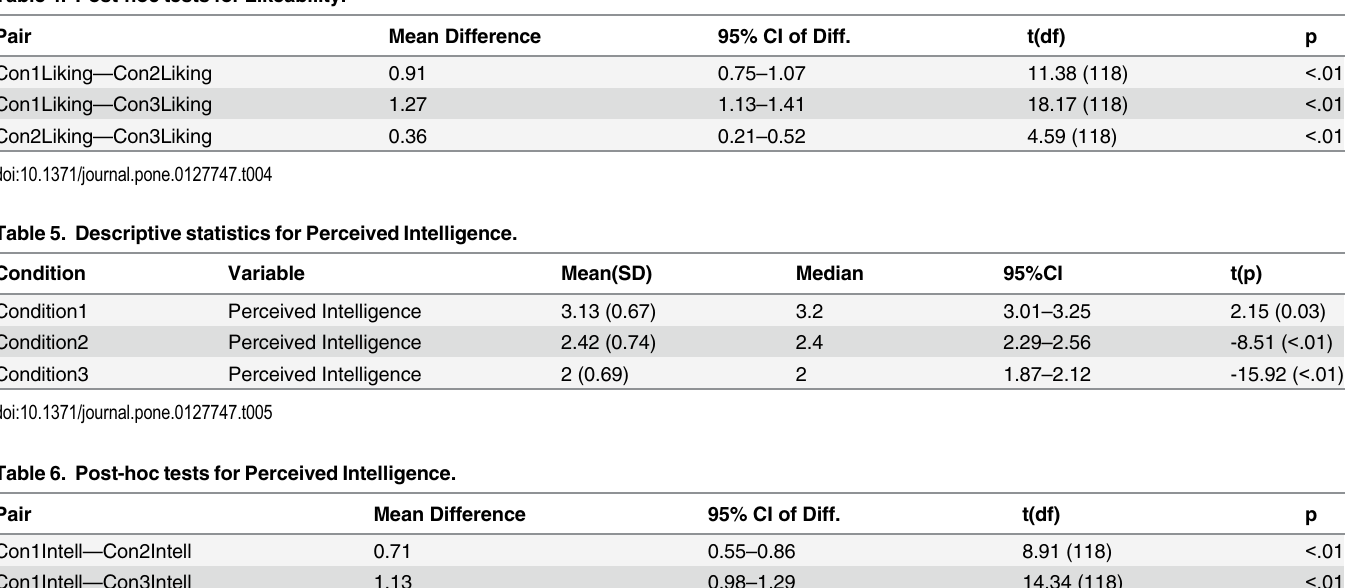
Table 4. Post-hoc tests for Likeability.